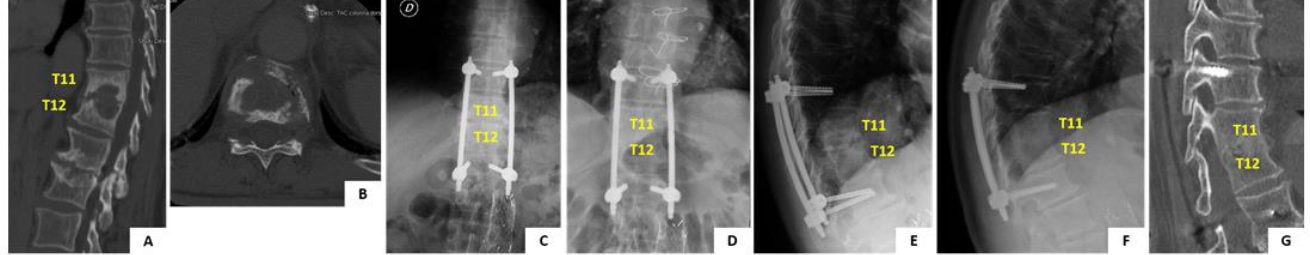
Figure 5. Pre- and post-operative imaging of the case report detailed in the manuscript. Panels ( A , B ) show sagittal and axial CT scan imaging of the T11–T12 infected level. Panels ( C , D ) show comparison of standing AP X-ray imaging of the spine immediately after surgery and at 10 years follow-up. Instrumentation is noted with pedicle screws and rods. The instrumentation is bridging the infected level. Panels ( E – G ) show comparison of standing lateral view X-ray imaging of the spine immediately after surgery and at 10 years follow-up. No mobilization of the instrumentarion is noted, the infected level is completely fused and segmental kyphosis is preserved.